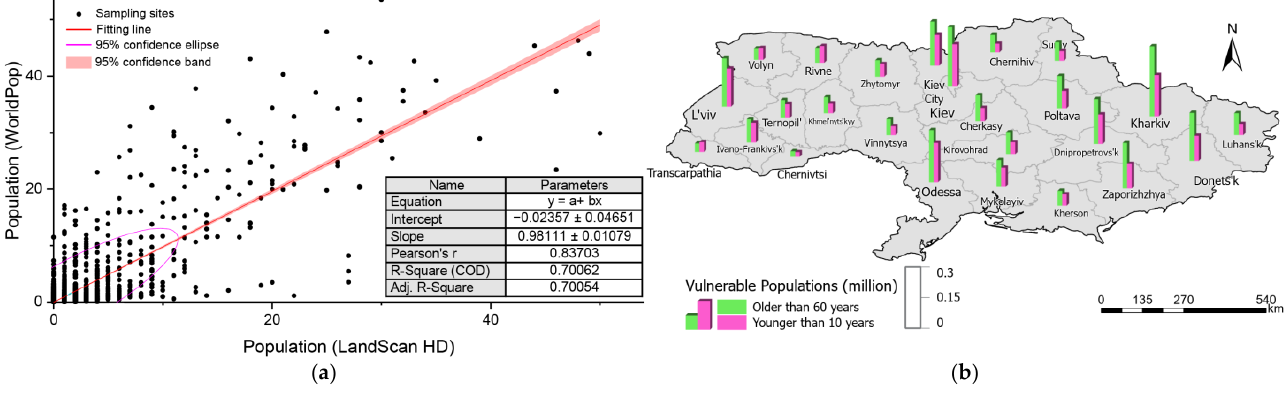
Figure 7. ( a ) Verification of population correlation from WorldPop and LandScan HD products; ( b ) The estimated affected vulnerable populations of the Ukrainian oblasts within the power shortages triggered by the Ukrainian-Russian conflict.